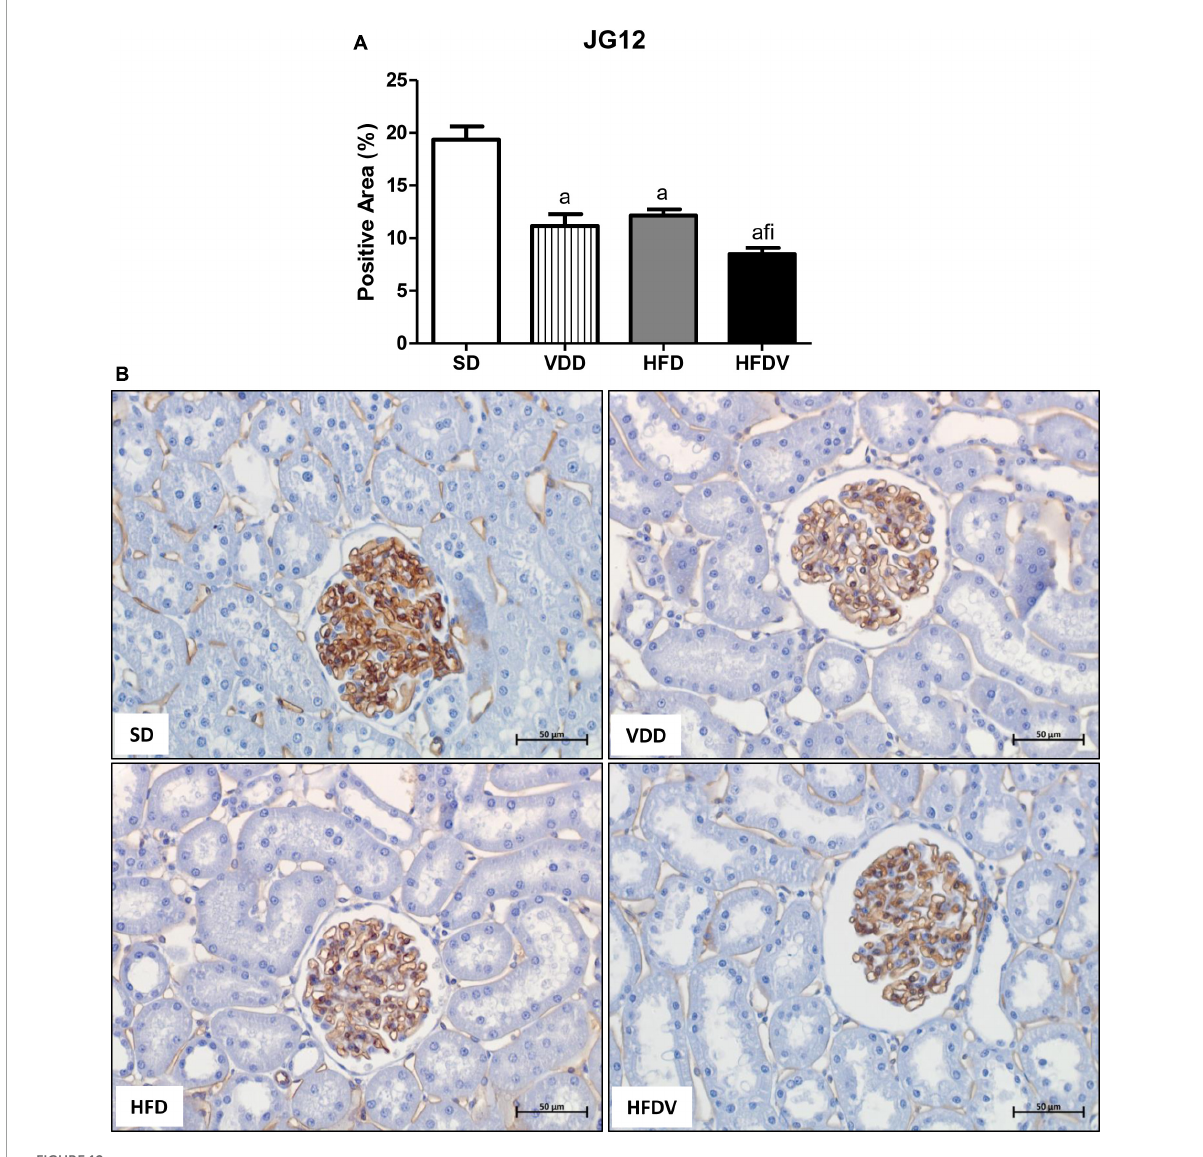
FIGURE12 Immunohistochemical analysis for aminopeptidase P (JG12) expression by glomerular tuft area in the renal tissue evaluated after the 90-day protocol in rats submitted to renal ischemia-reperfusion insult on day 45 treated with standard diet (SD), vitamin D-free diet (VDD), high-fat diet (HFD) or high-fat vitamin D-free diet (HFDV). (A) Bar graph of JG12 expression values. (B) Representative photomicrographs of immunostaining for JG12 in the renal cortex from an SD, VDD, HFD, and HFDV rat ( × 400). Data are mean ± SEM. a p < 0.001 vs. SD; f p < 0.05 vs . VDD; i p < 0.05 vs .